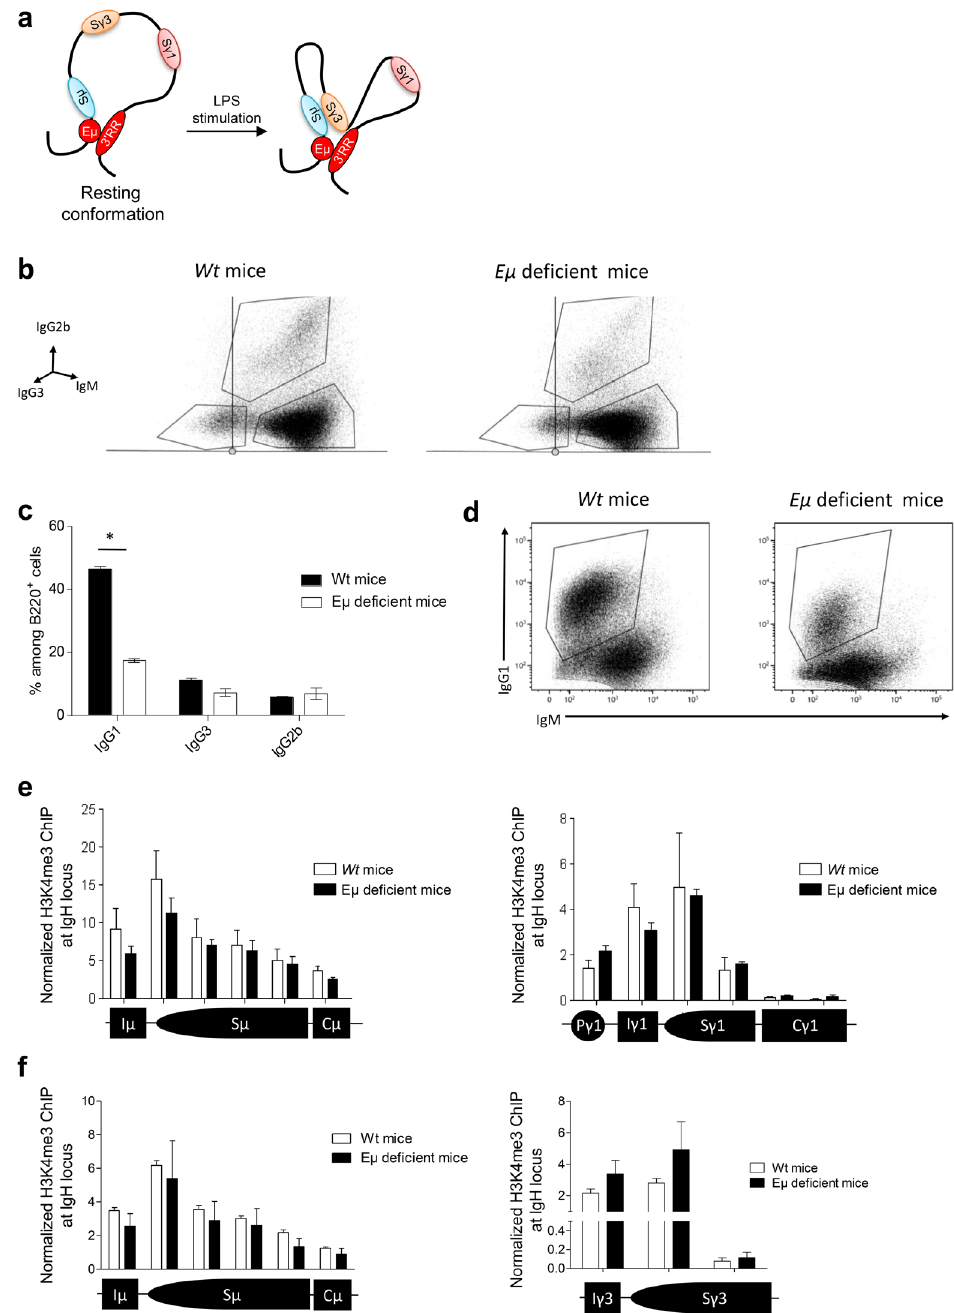
Figure 1. E μ and CSR. ( a ) Schematic 3D conformation of the IgH locus during LPS-induced CSR. 3C experiments indicated that E μ and the 3 ′ RR are in close proximity in resting B cells. After appropriated stimulation the activated S acceptor region gets closer the S μ donor region. Adapted from Wuerffel et al . 4 . ( b ) Flow cytometry analysis of IgG 3 and IgG 2b CSR in E μ -deficient B-cells. Cells were stimulated 4 days with LPS. Cells were labelled with anti-B220-BV421, anti-IgG 3 -FITC, anti-IgG 2b -PE and anti-IgM-PC7 antibodies. Cells were gated on B220 + B-cells. One representative experiment out of four is shown. ( c ) Quantitative analysis of IgG 1 , IgG 3 and IgG 2b CSR. Results are reported as mean ± SEM of 4 independent experiments. * p < 0.05, Mann- Whitney U -test. ( d ) Flow cytometry analysis of IgG 1 CSR in E μ -deficient B-cells. Cells were stimulated 4 days with LPS + IL-4. Cells were labelled with anti-B220-BV421, anti-IgG 1 -PE and anti-IgM-PC7 antibodies. Cells were gated on B220 + B-cells. One representative experiment out of four is shown. ( e ) H3K4me3 epigenetic mark in S μ and S γ 1 during IgG 1 CSR ChIP assays were performed with CD43 − splenic B-cells from E μ -deficient and wt mice. Cells were stimulated with LPS + IL-4 for 2 days. Background signals from mock samples with irrelevant antibody were subtracted. Values were normalized to the total input DNA. Data are the mean ± SEM of 3 independent experiments with 2 mice. ( f ) H3K4me3 epigenetic mark in S μ and S γ 3 during IgG 3 CSR. Cells were stimulated with LPS for 2 days. Same protocol as in part